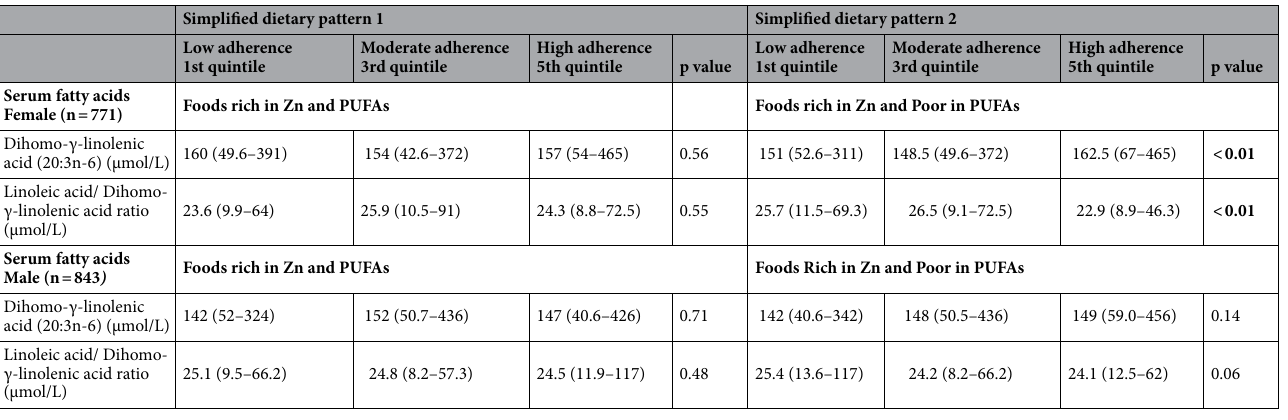
Table 5. Serum fatty acids across quintiles 1 of the simplified dietary patterns scores. Female and male populations NHANES 2011–2012. 1 Differences throughout quintiles for continuous variables were tested using linear trend. The top number in each cell is the median value and the data in parenthesis is the range.